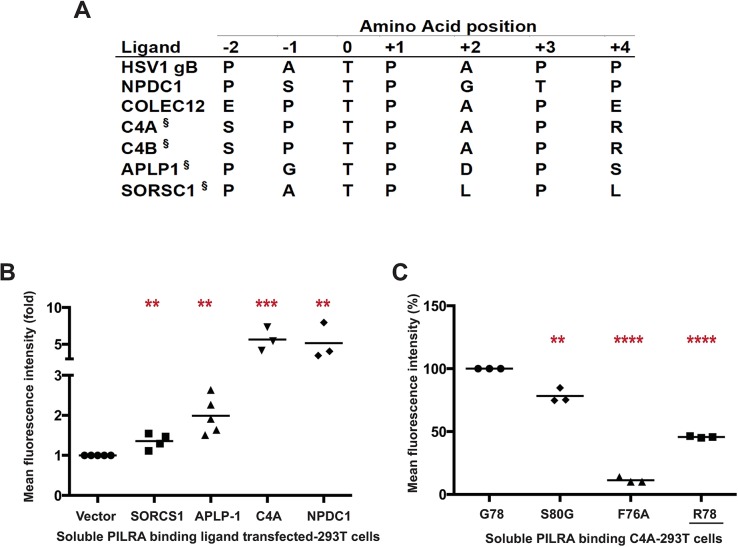
C4A is a novel ligand for PILRA.A) Comparison of the peptide sequence around the O-glycosylated Thr (position 0) of known and putative (§) PILRA ligands. B) 293T cells were transfected with putative ligands of PILRA (SORCS1 ECD, APLP1 ECD. or full length C4A) fused with C-terminal glycoprotein D (gD) tag and GPI anchor, or full length NPDC1 as positive control. Binding of G78 (AD risk) PILRA to ligand-transfected cells was analyzed by flow cytometry. Results are fold-increase in binding to each putative ligand compared to vector control for each experiment. C) 293T cells were transfected with full length C4A fused with C-terminal gD tag and GPI anchor. Binding of different PILRA variants to C4A-transfected cells was analyzed by flow cytometry. Results are the percentage of MFI of PILRA-mFc binding on ligand-transfected cells considering G78 (AD risk) PILRA binding as 100% for each experiment. Statistical analysis is two-tailed unpaired t-test (p values <0.05 = *, <0.005 = **, <0.0005 = ***, <0.0001 = ****) performed on 3–5 independent experiments.